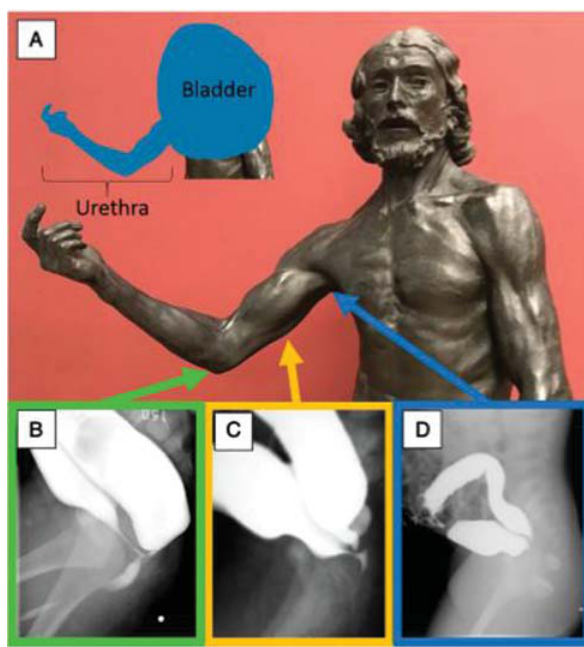
Fig. 3 Auguste Rodin ’ s Saint John the Baptist sculpture (1880) in the Musée d ’ Orsay, Paris, France. The right arm is used to represent the course of the male urethra ( A ). The relative positions of the male urethra are represented by the various levels of the arm of the statue. The elbow represents the bulbar urethra ( B ), the humerus represents the prostatic urethra ( C ), and the axilla represents the bladder neck ( D ). Reprinted with permission from Halleran et al.